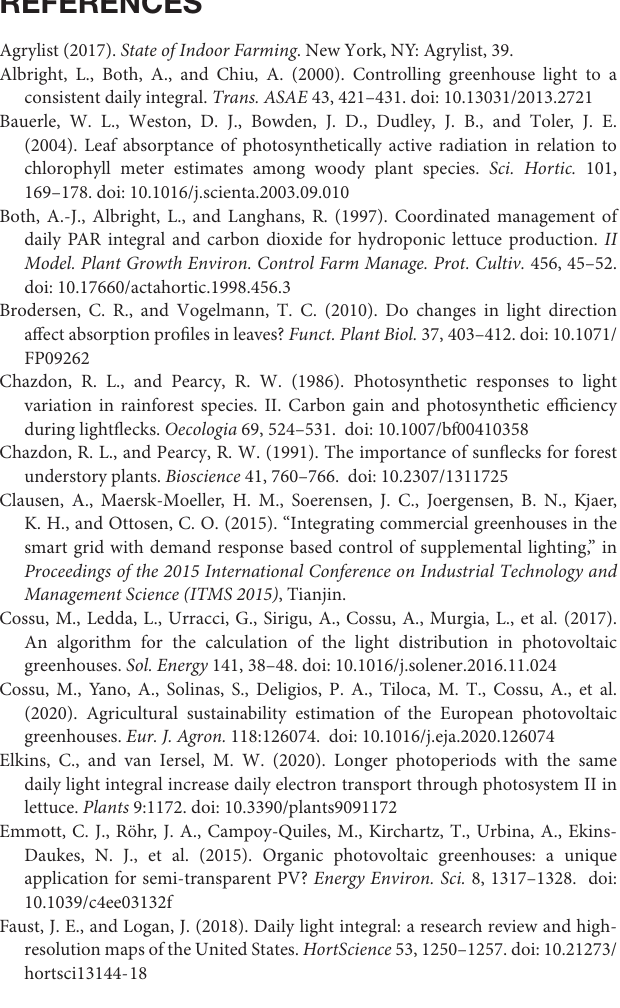
Supplementary Figure 1 | Images of ‘Little Gem’ (left and middle top) and ‘Green Salad Bowl’ (right and middle bottom) lettuce ( Lactuca sativa ) grown at PPFDs of